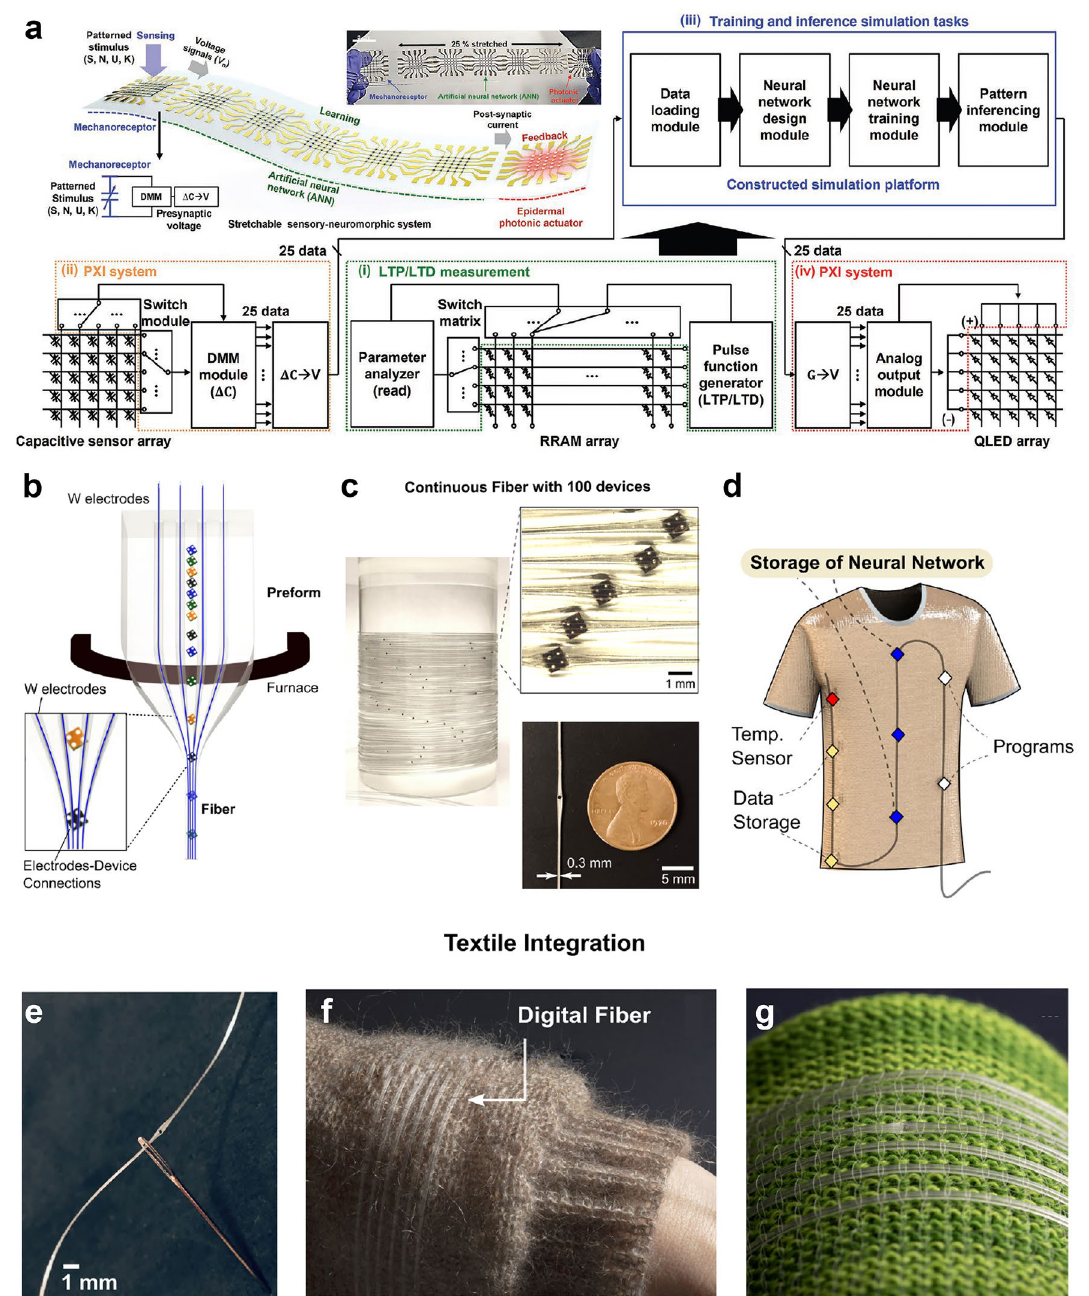
Fig. 31 Neural network worked on soft device. a Schematic of the SSNS (top left, inset image denotes photographs of the stretched SSNS) and overall operation process of the SSNS. (i) Extraction of LTP/LTD data from the stretchable artificial synapse. (ii) Capacitive measurement by the pressure sensor array. (iii) Training/inferencing process in online MLP using the extracted LTP/LTD data. (iv) Inferencing process in online MLP to deliver feedback processed information to the QLED photonic actuator. Reproduced with permission [346]. Copyright (2021), Wiley–VCH. b Thermal drawing of the digital fiber performed by feeding conductive W wires into the empty channels. At the preform level, the W wires are spaced far apart with a polymeric barrier separating the device and the wires. The inset showing the converging of the four W elec- trodes toward the four pads at the necking region of the preform-to-fiber transition. c Photograph of a spool containing continuous digital fibers with 100 embedded devices (left). Magnified optical image of the fiber array showing that the digital devices are all rotated to the critical angle with connections to wire electrodes (right). Photograph showing the size difference between the fiber and a coin (bottom). d Schematic of the shirt integrated with a digital fiber including sensors, data storage, customizable programmers, and a neural network stored within its memory devices. Integration of the digital fiber e through a needle, f in the sleeve of a sweater, and g in a cotton-based fabric. Reproduced with permis- sion [347]. Copyright (2021), Springer